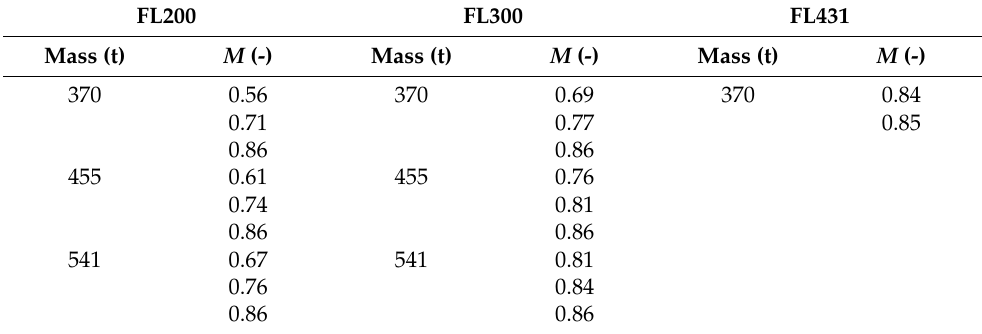
Table A5. Realistic flight operation conditions for A380-861 at FL200, FL300, and FL431.